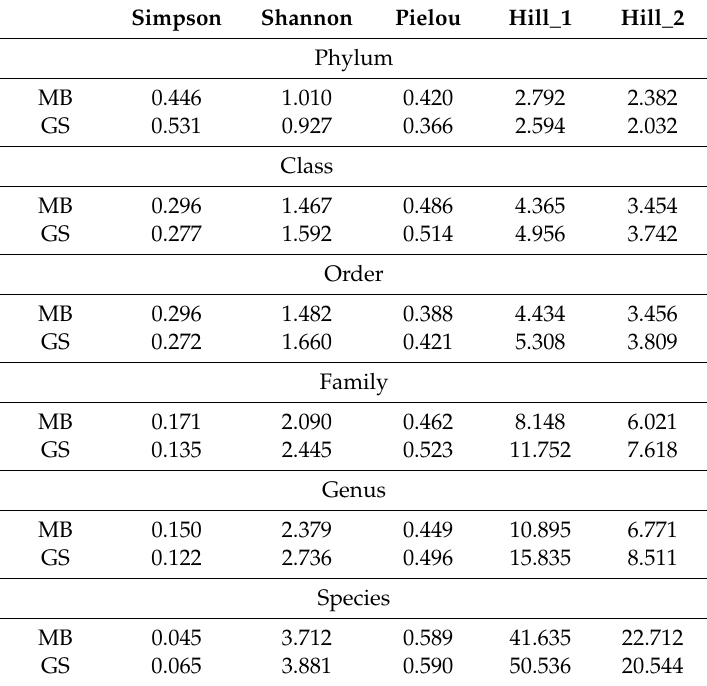
Figure 2. Beta diversity of the two study groups. Bray-Curtis beta diversity and Principal Coordinates Analysis (PCoA) the inter-sample variation highlighted a significant separation between the structural composition of the gut microbiota among study groups. (GM = German Shepherd, MB = mixed breeds).